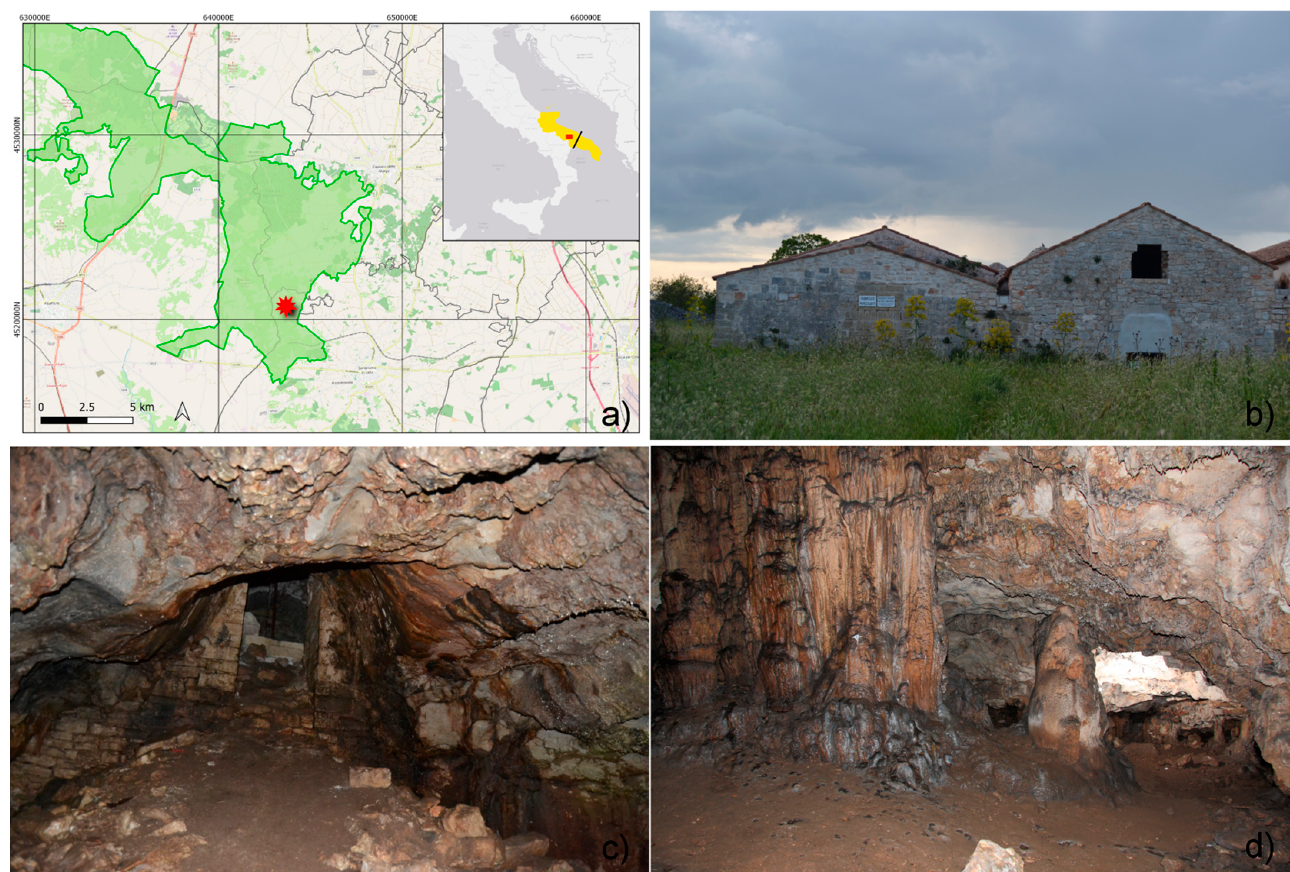
Figure 1. ( a ) Localization of the study site (red star) just inside the Alta Murgia National Park (green), the black line is the cross-section in Figure 3. ( b ) The front of the ancient buildings built over the cave. ( c ) The entrance view from the cave inside, delimited by rock walls of the ancient church foundations. ( d ) View of the central cave corridor with massive columns.